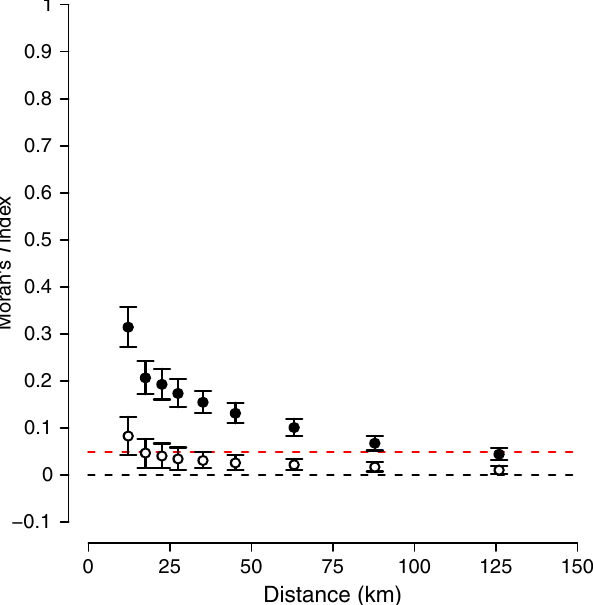
Figure 2 | Ecological determinism of the climatic debt in forests. The effect of each variable is measured by the mean slope of the climatic debt observed in French forest herbaceous plant communities between 1987 and 2008 versus this variable over the 5,000 subsamples of the PLS0 model. Error bars show 95% confidence intervals. Only significant variables are shown (bootstrap test for difference of slope values to 0: P o 0.01, n ¼ 5,000) and classified by categories of factors. Temporal changes in species habitat aggregation, road proximity, human population density, temperature heterogeneity, precipitation change, baseline precipitation conditions and time were not significant (Supplementary Table 1). Negative and positive slopes mean mitigating and amplifying effects, respectively, on the climatic debt. Factors involved in species’ persistence and migration are specified in blue and red, respectively; purple depicts factors involved in both species’ persistence and migration; white depicts environmental pressures for species. C N , interspecific competition for soil nitrogen; C W , interspecific competition for water; dHA , temporal change in species habitat aggregation; HP , past species habitat patches’ proximity; N , soil nitrogen content; pH , soil acidity; TO T , thermal-stress tolerance; TO W , water-stress tolerance.